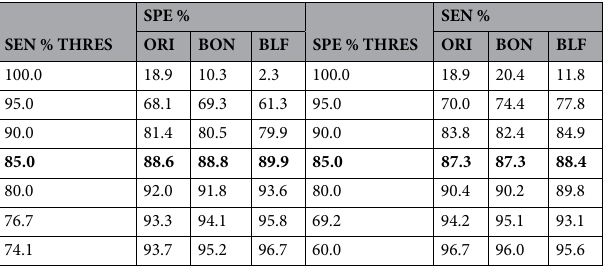
Table 5. Performances base on Test-10 dataset using different thresholds. In bold, three models achieve high efficiency, especially BLF that reaches SPE near 90% with SEN